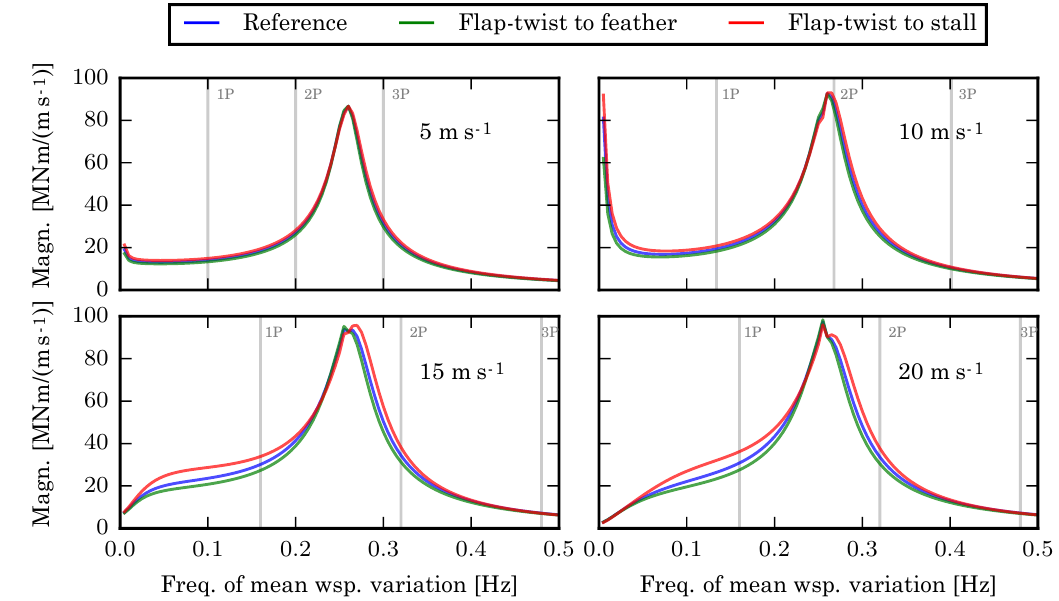
Figure 19. Frequency response of the tower bottom fore–aft moment to mean wind speed variation between 0.0 and 0.5Hz for steady-state operation at mean wind speeds of 5, 10, 15, and 20ms − 1 . The coupled blades have a constant coefficient of γ y = ± 0 .